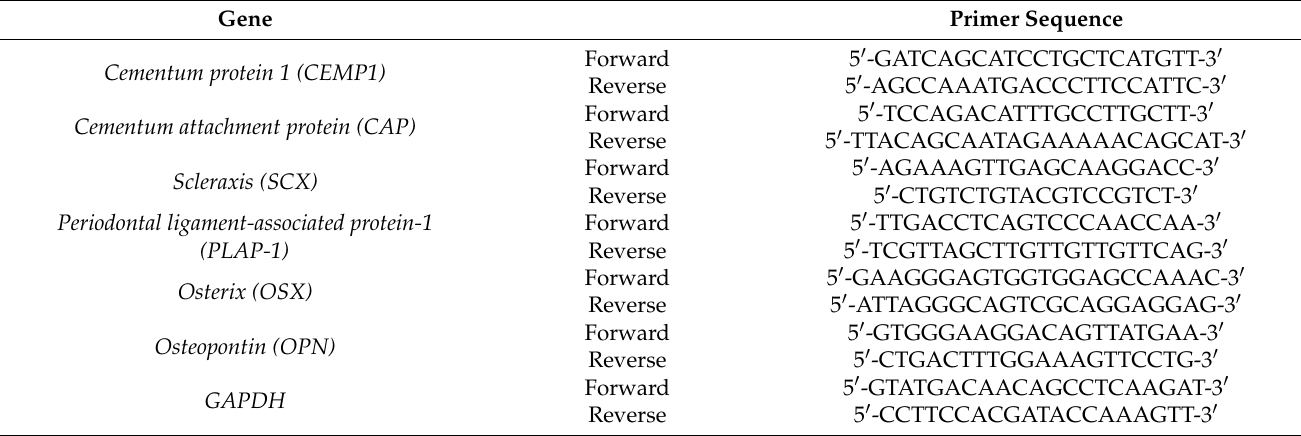
Table 1. Primers used for the quantitative real-time-PCR (qPCR). Gene Primer